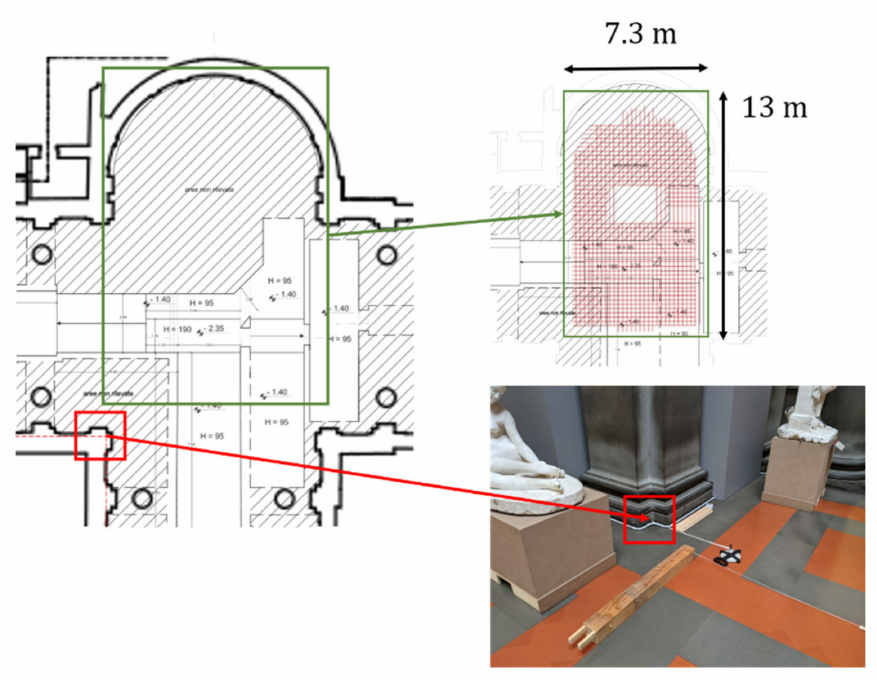
Figure 6. Survey area and reference